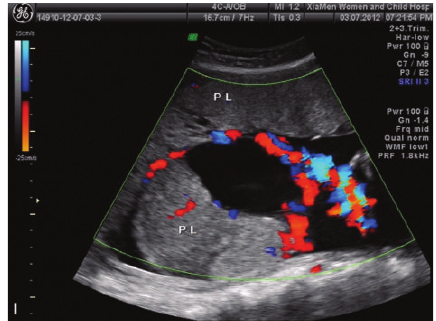
Figure 1: Transabdominal ultrasound showing a bulky placenta contained a mixed-echogenic mass measuring approximately 83 × 30 × 56 mm.